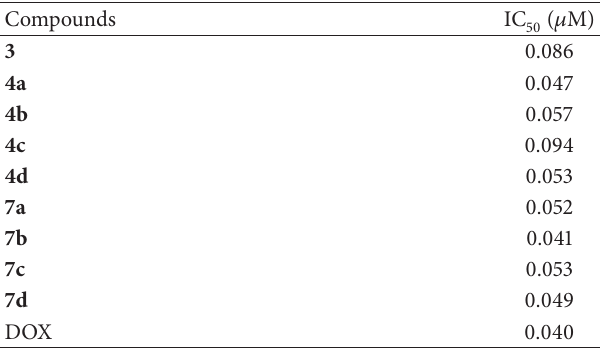
Table 3: Cytotoxic activity of the newly synthesized selected derivatives on the liver HepG2 cancer cell line in comparison to the traditional anticancer drug